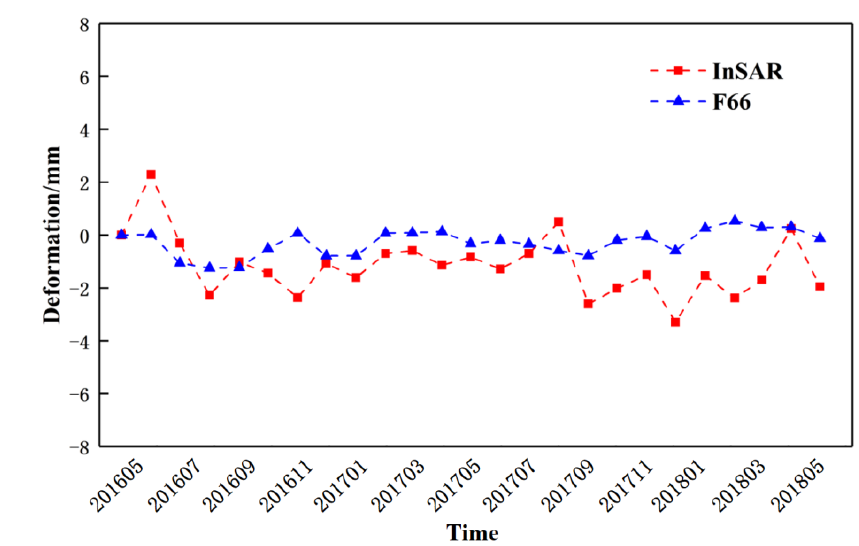
Figure 8. The time series relationship between the leveling observation data F66 and the PSInSAR result at groundwater monitoring well W66.